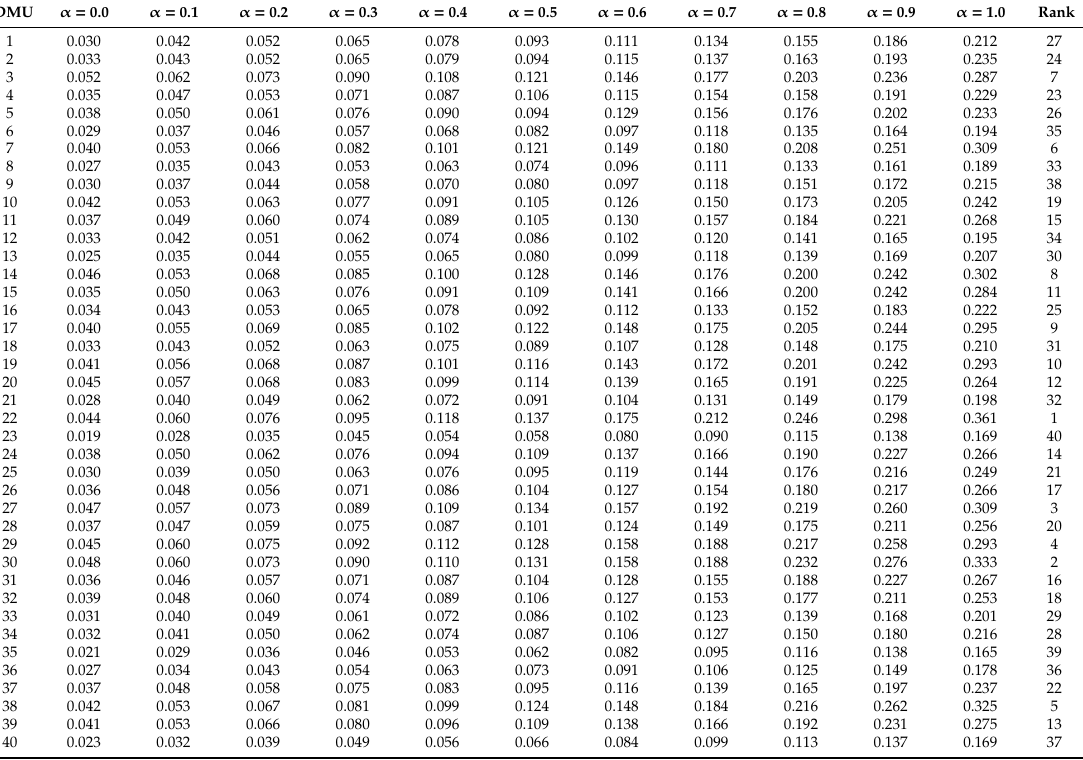
Table 4. Lower e ffi ciency estimates and ranking of Kao and Liu [20] for dataset 2. DMU α =